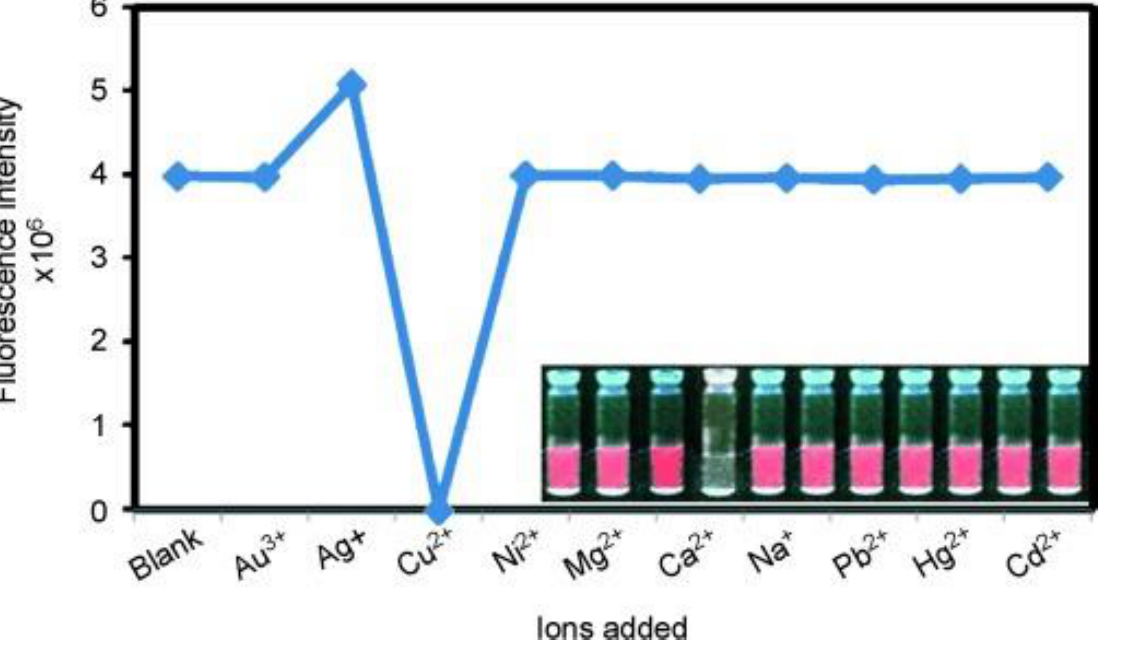
Figure 14. Changes in the luminescence intensity of Au 23 NCs after introducing different cations (the inset is the picture under UV light). Reproduced with permission from [66]. Copyright © 2009 WILEY‐VCH Verlag GmbH & Co. KGaA, Weinheim .